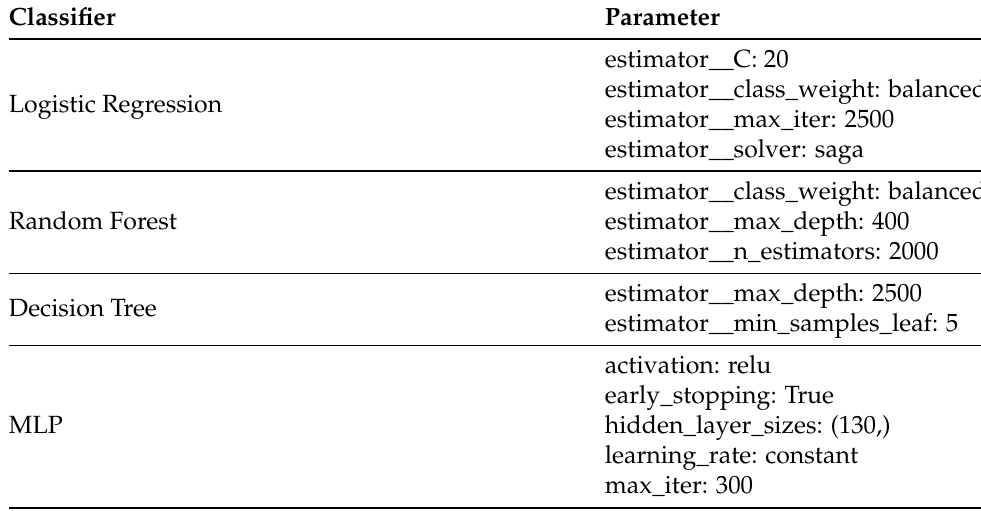
Table 3. Allergen classification classifier parameters after grid